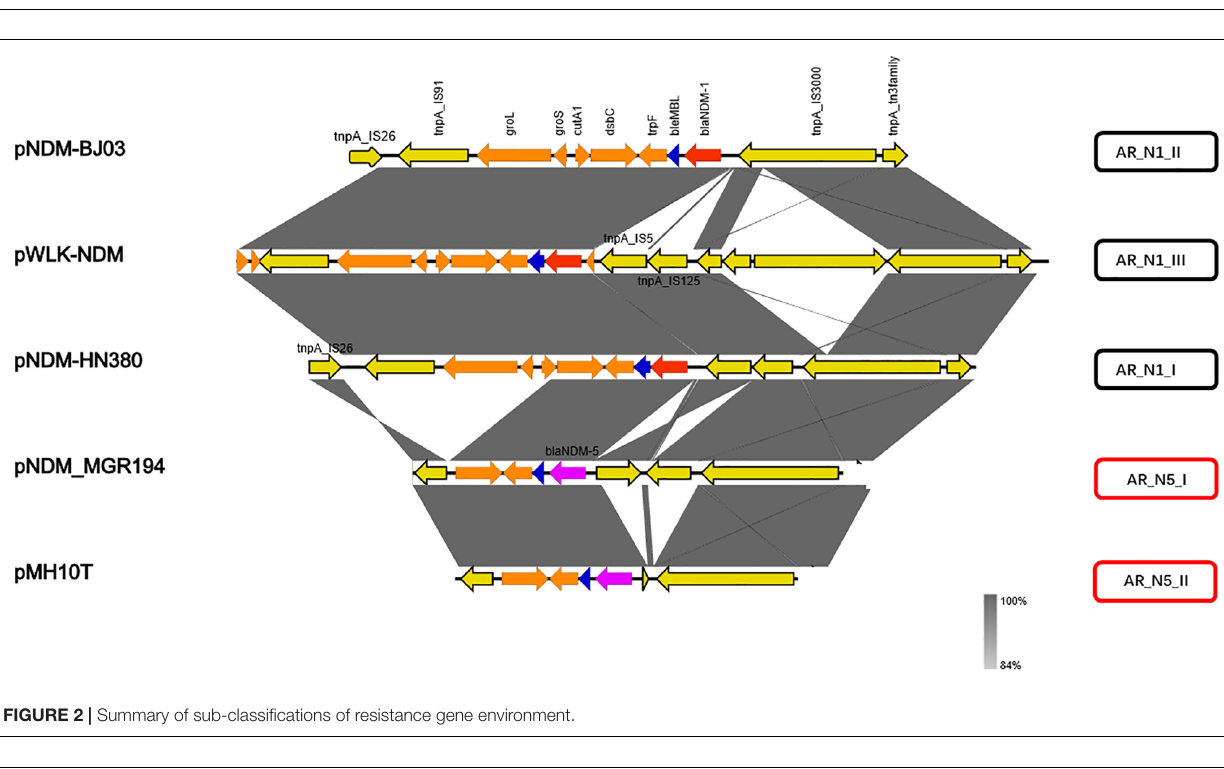
FIGURE 1 | Plasmid backbone region map (dotted line indicates gene load region).